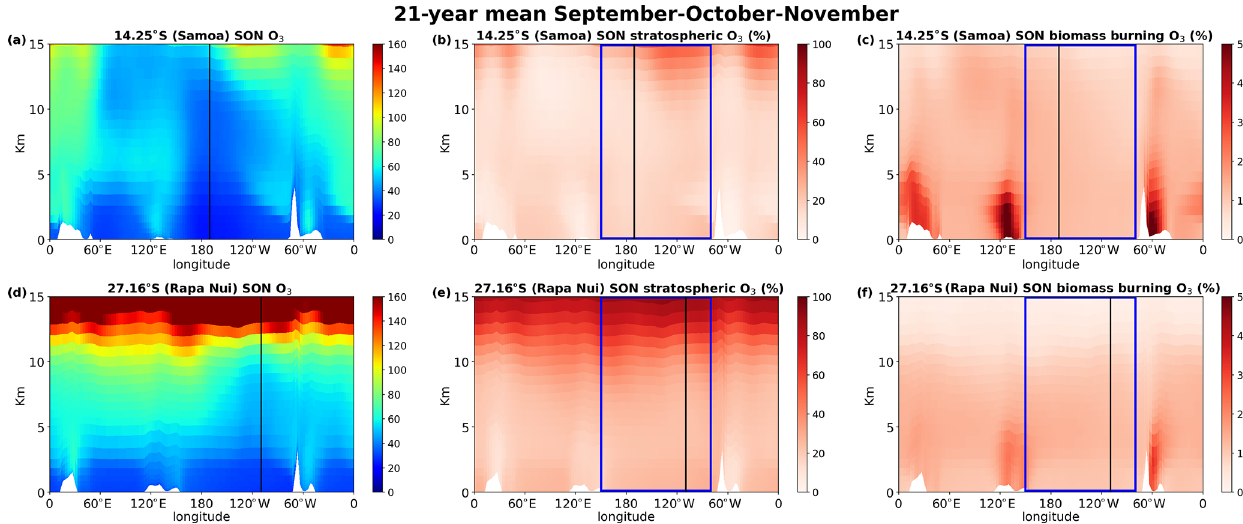
Figure 9. Cross section of the 1994–2014 average atmospheric concentration of O 3 at the latitude of Samoa (a–c) and Rapa Nui (d–f) for Southern Hemisphere spring (September–October–November) as calculated by the TM4-ECPL. The left column shows the O 3 mixing ratio, the middle column the percentage of O 3 originating from the stratosphere, and the right column the percentage contribution of biomass burning to the O 3 concentrations (note that the third column scale is up to 50%). The black vertical lines indicate the location of Samoa in the upper panels and Rapa Nui in the lower panels, and the blue rectangle encloses the region of